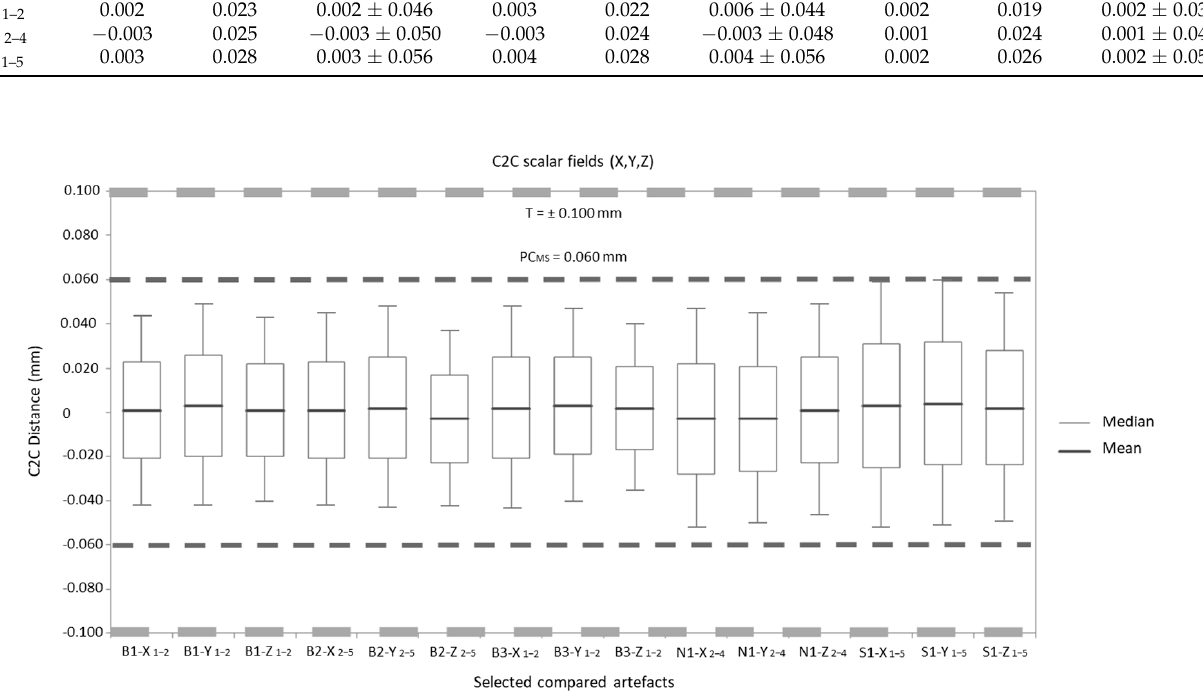
Figure 10. Box-Plots showing the M+2SD (whiskers) of scalar field C2C-X, C2C-Y, C2C-Z among 3D point cloud models compared after registration with ICP method, referenced to PC MS = 0.060mm and T (tolerance limit).